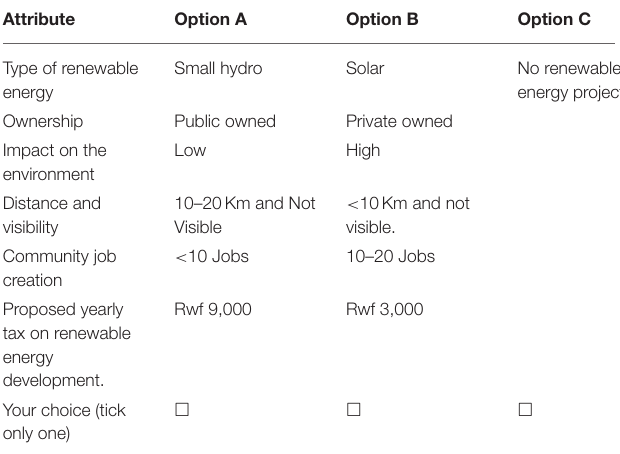
TABLE 1 | Attributes and levels in the choice tasks. Description